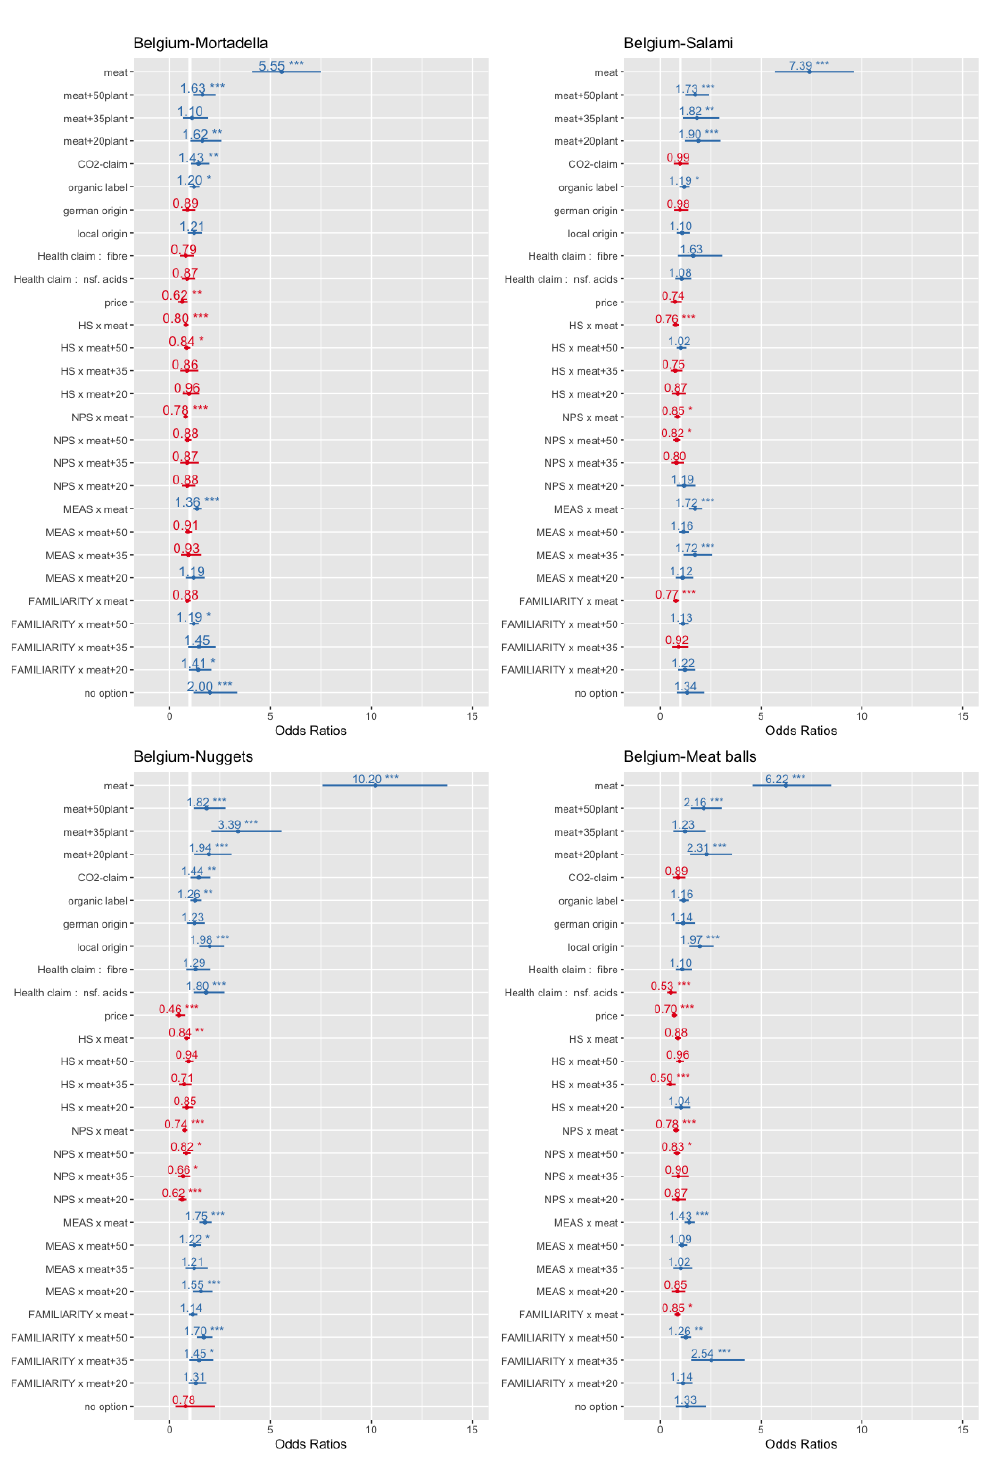
Figure 3. Odds ratios—estimations for Belgium. ∗ p < 0.1; ∗∗ p < 0.05; ∗∗∗ p <